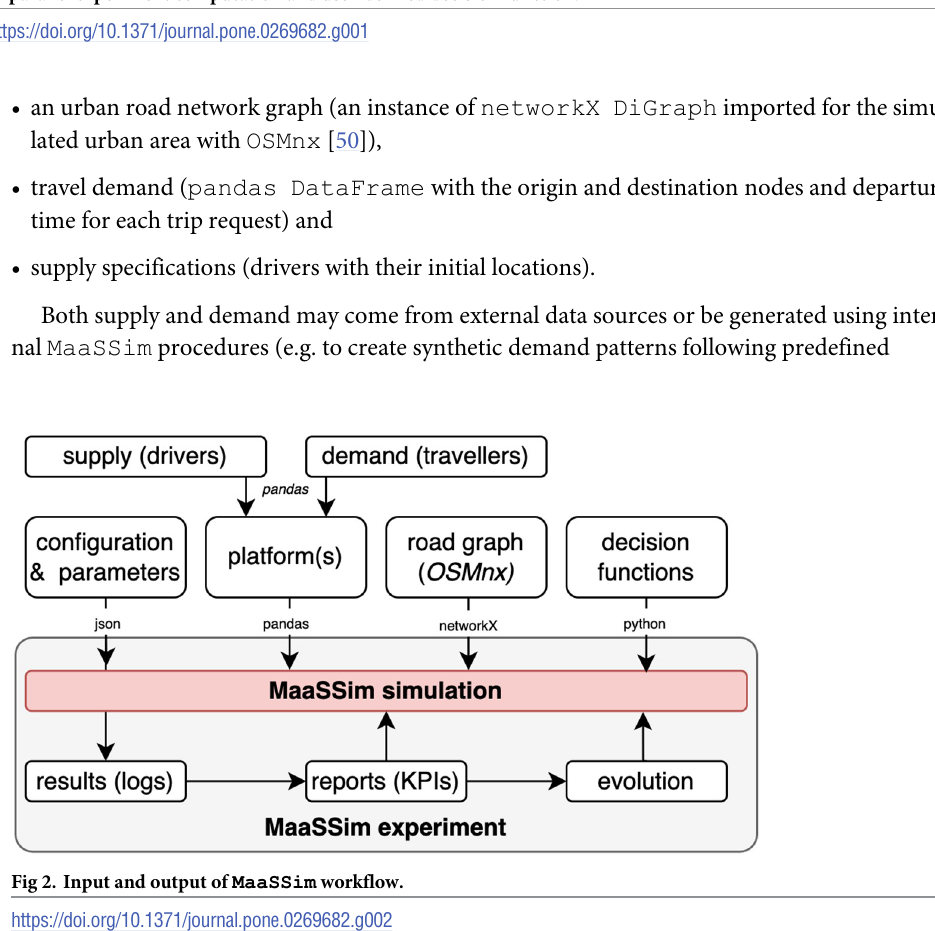
Fig 1. MaaSSim usage at glance: Starting from a single simulation, through modifying input and configuration, up to parallel experiment computation and user-defined decision function.